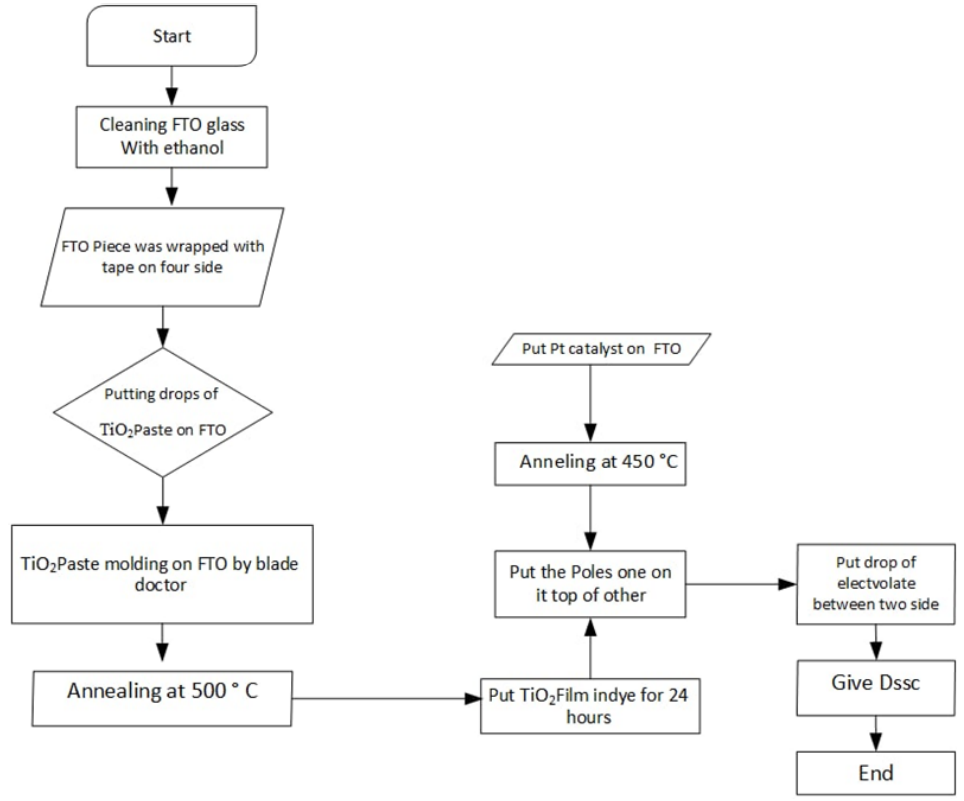
Figure 4. Schematic diagram of DSSCs fabrication process.